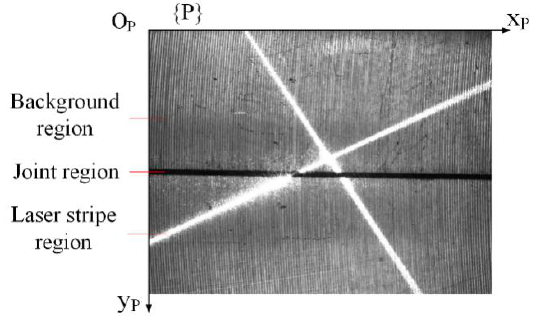
Figure 3. The grabbed ROI (region of interest).